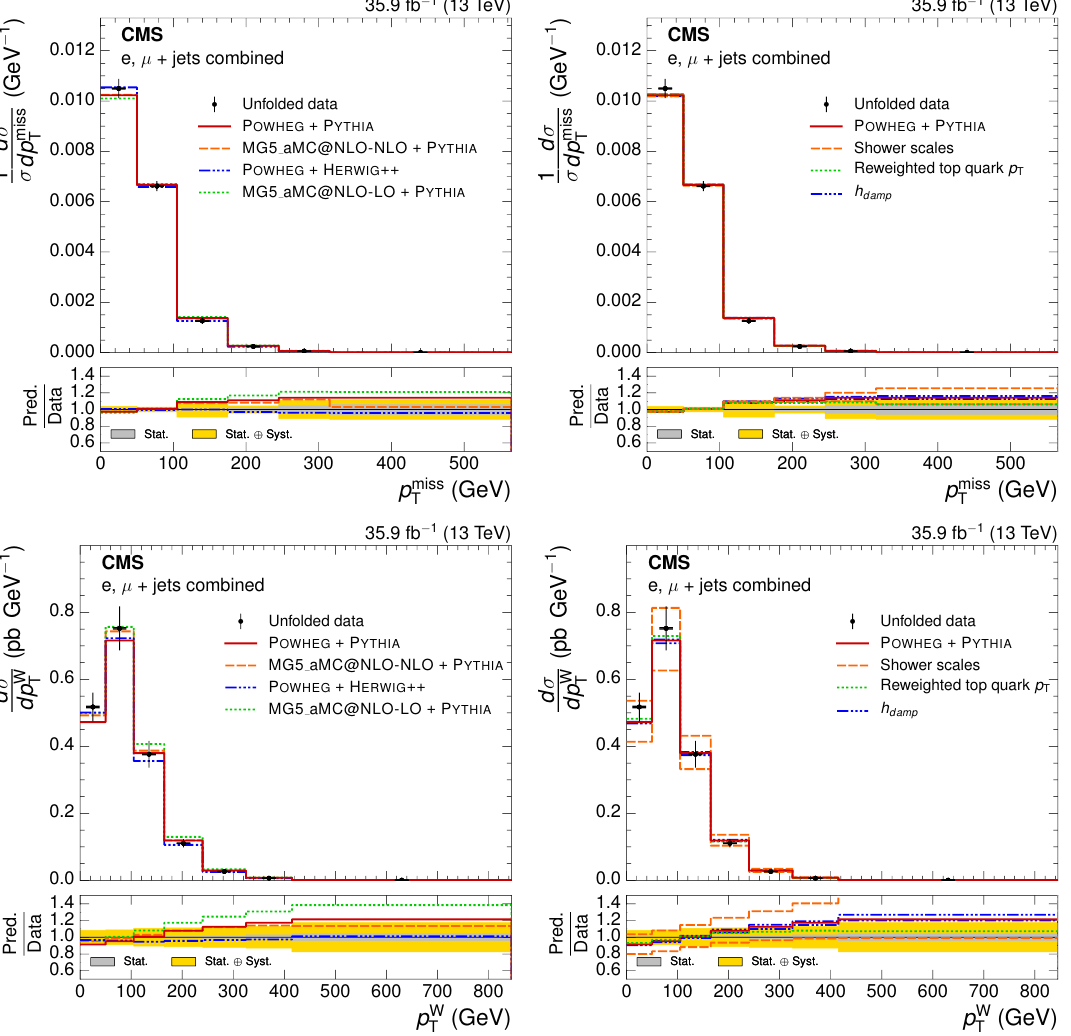
Figure 9 . Absolute p miss (upper) and p W (lower) di(cid:11)erential tt cross sections, compared to di(cid:11)erent T T tt simulations in the left plots, and compared to the powheg + pythia simulation after varying the shower scales, and h damp parameter, within their uncertainties, in the right plots. The vertical bars on the data represent the statistical and systematic uncertainties added in quadrature. The bottom panels show the ratio of the predictions to the